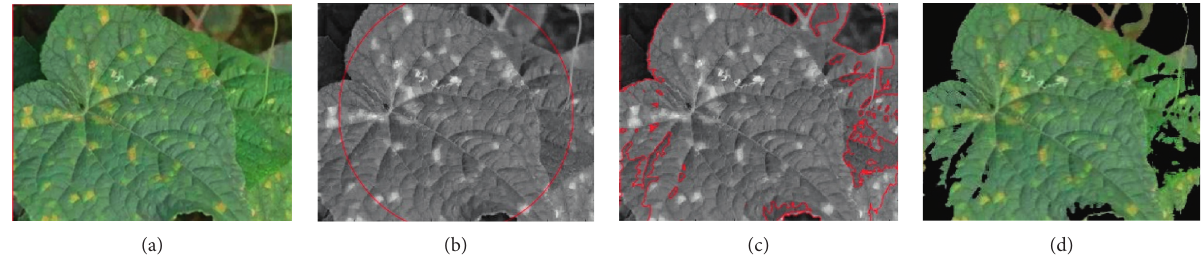
Figure 4: The result of Chan–Vese algorithm segmenting bacterial plaque diseased leaf: (a) image capture; (b) initial zero level set; (c) contour image after 500 iterations; (d) segmentation results.